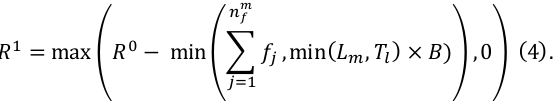
is the link 𝐿 𝑚